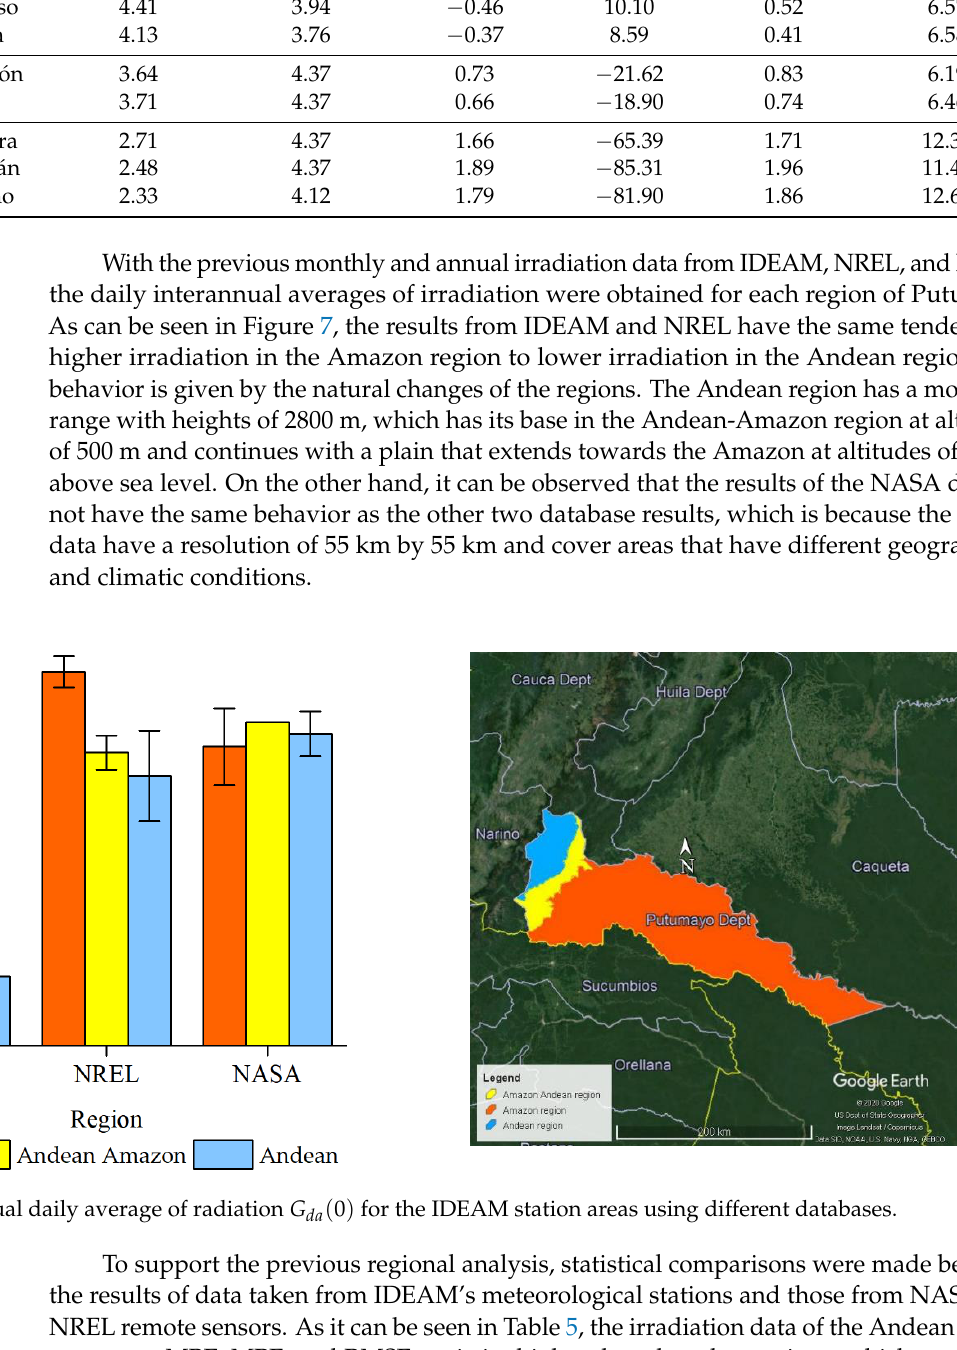
Table 5. Comparison of IDEAM-NASA and IDEAM-NREL irradiance values 𝐺 𝑑𝑎 by region. Data and Statistics